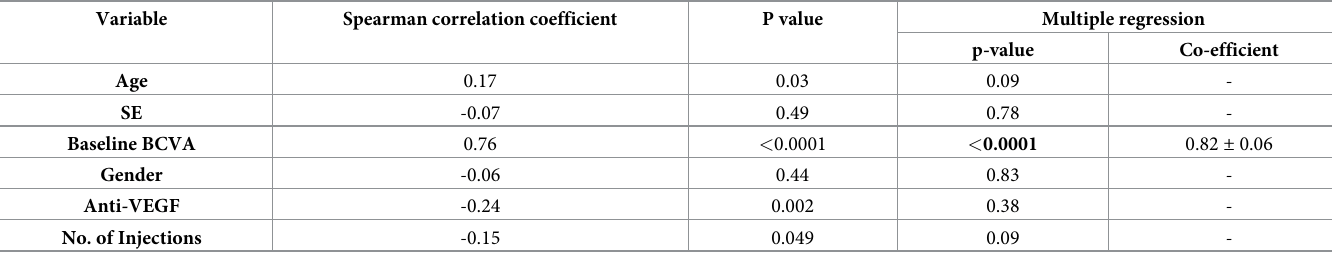
Table 4. Shows the multiple linear regression for post-injection BCVA as the dependent